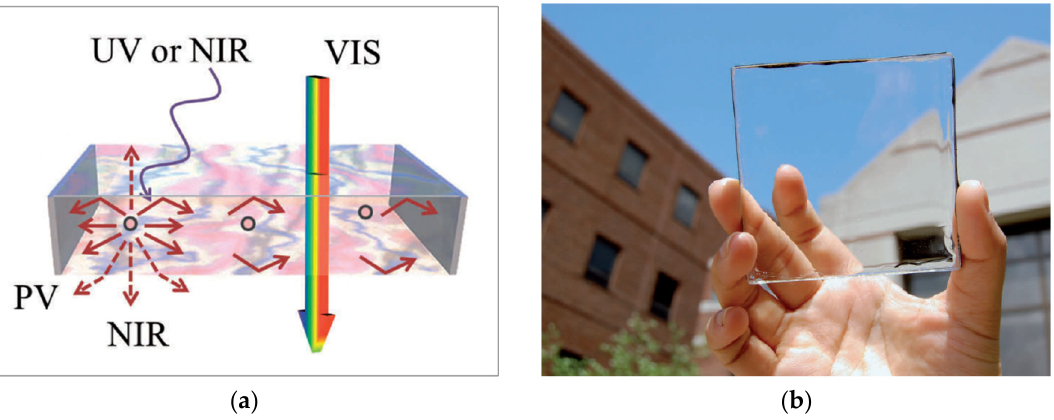
Figure 10. A solar harvesting system using small organic molecules that are tuned to absorb specific non ‐ visible wavelengths of solar radiation and letting the visible solar radiation pass straight through ( a ), hence resulting in a solar cell that creates solar energy while still allowing people to see through a clear glass with no color distortions ( b ) [45].